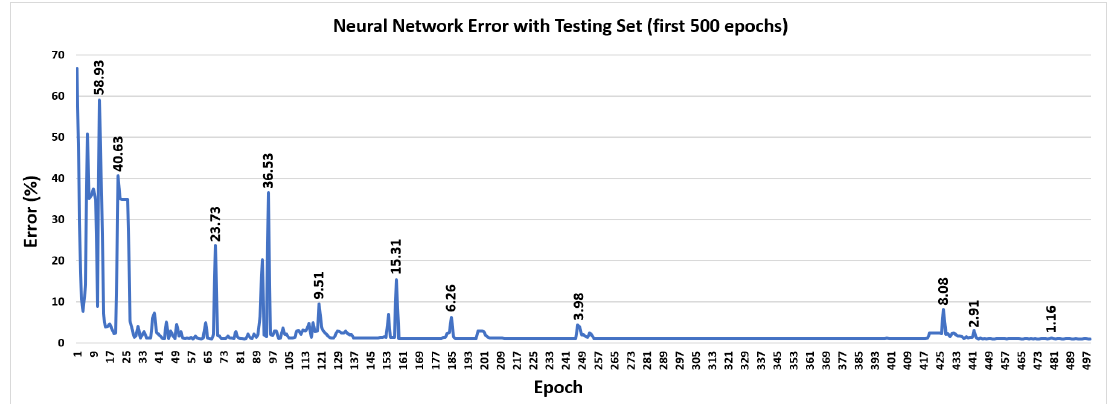
Figure 11. Error obtained during the training process after each epoch (epochs 1 to 500 represented) using the testing